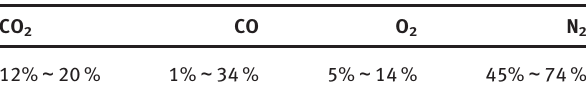
Table 2: Electric arc furnace gas content. CO